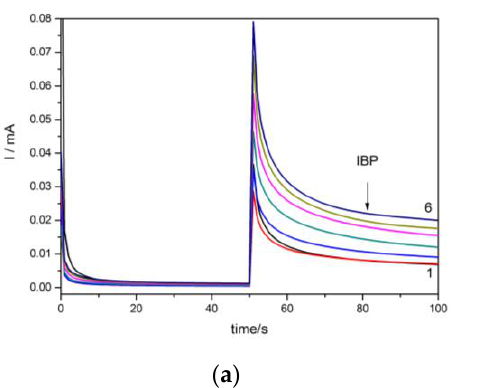
Figure 3. Cyclic voltammogram recorded on HKUST-CNF electrode in 0.1 M Na 2 SO 4 supporting electrolyte (curve 1) and in the presence of various IBP concentrations: curves 2–7: 1–6 mg · L − 1 IBP; potential scan rate: 0.05 V · s − 1 ; potential range: − 0.5 to +1.5 V/SCE. Inset: Calibration plots of the currents recorded at E = +1.25 V vs. SCE versus IBP concentrations.